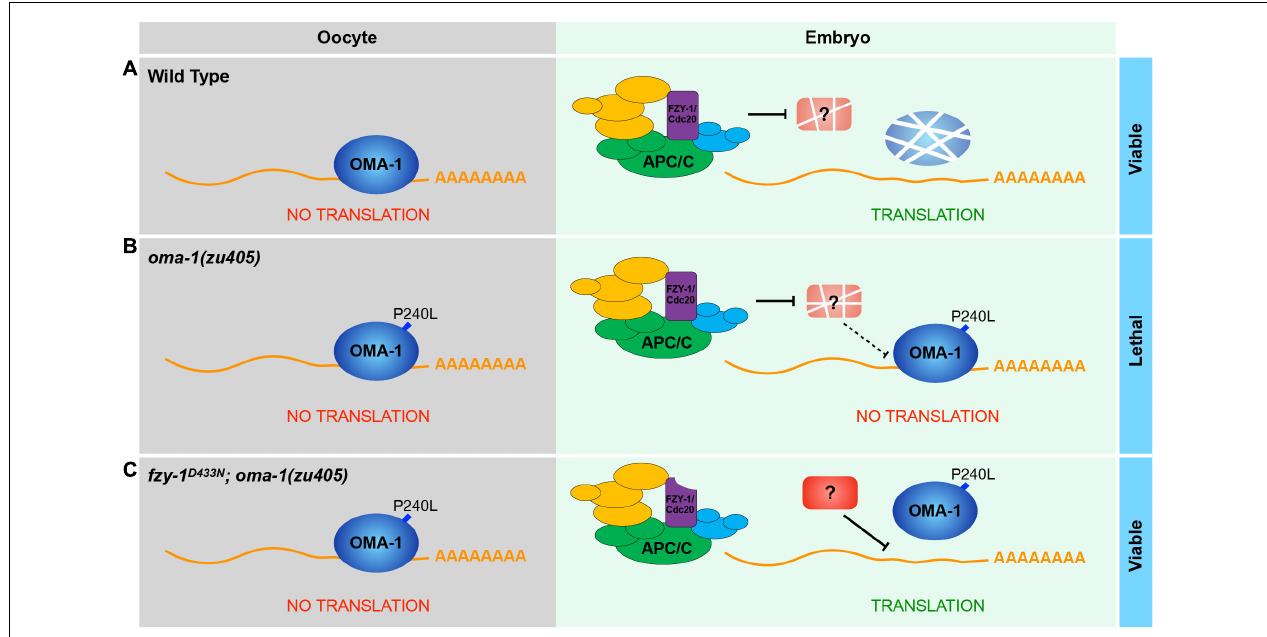
FIGURE 7 | A proposed model to show how APC/C complex and OMA-1 are coordinated to regulate the oocyte-to-embryo transition. (A) In the wild type, OMA-1 binds to 3 (cid:48) UTR of its cognate mRNA to repress translation and undergoes rapid turnover in the oocyte-to-embryo transition. Maternal mRNAs can be translated normally in early embryos. (B) In the oma-1(zu405) mutant, the gain-of-function mutation P240L stabilizes OMA-1, causing OMA-1 continuously binds to its targets and repress their translation in early embryos, which eventually leads to embryonic lethality. (C) When the function of APC/C is perturbed ( fzy-1 D 433 N as an example), its substrates are not degraded. In this situation, P240L mutation still stabilizes OMA-1, however, the association between OMA-1 P 240 L and mRNA is weakened, which is probably regulated a potential APC/C